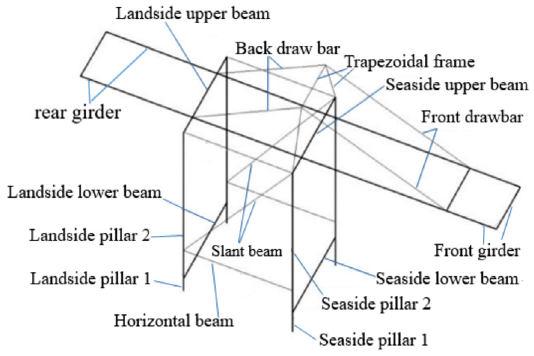
Fig. 1. Main components of